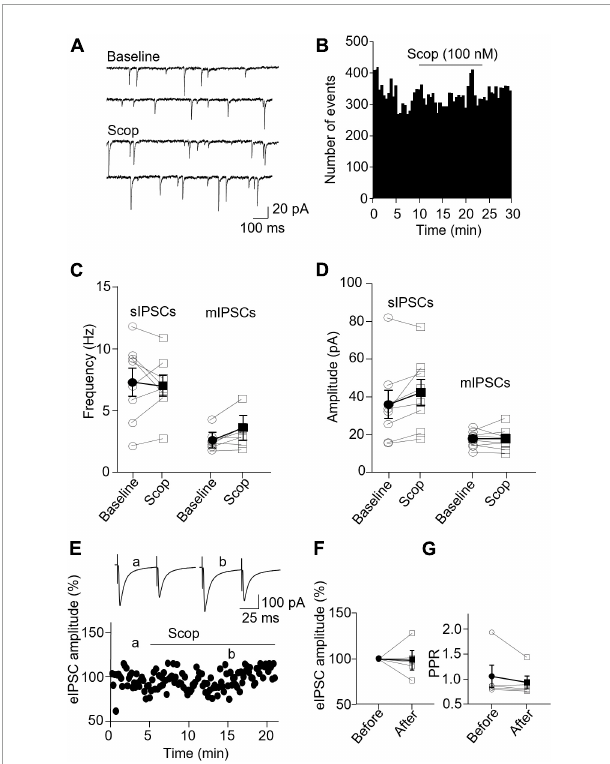
FIGURE7 Blocking mAChRs does not affect inhibitory synaptic transmission in PV interneurons. (A) Representative traces of sIPSCs from a PV interneuron before and after application of scopolamine. (B) A histogram shows the effect of scopolamine on sIPSC frequency in the PV interneuron. (C,D) Summarized data show the effect of scopolamine on sIPSC ( n = 8 cells/6 mice) and mIPSC ( n = 8 cells/6 mice) frequency and amplitude, respectively. (E) A representative experiment from a PV interneuron shows the effect of scopolamine on the amplitude of evoked IPSCs. Inserts: the traces of evoked IPSCs taken at the time indicated by a and b in the graph. (F,G) Summarized data show the effect of scopolamine on evoked IPSCs amplitude ( n = 5 cells/4 mice) and paired-pulse ratio, respectively.